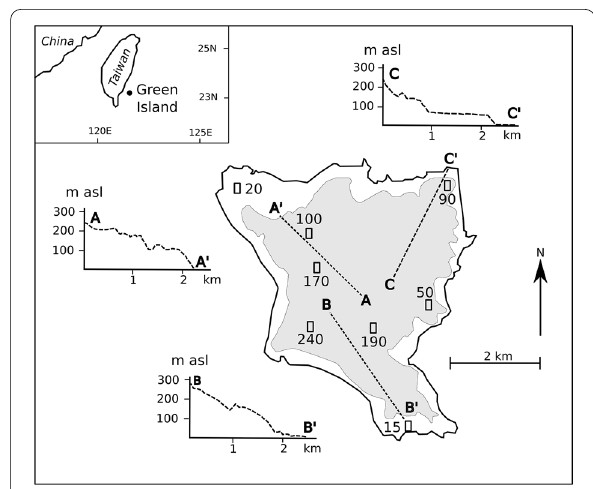
Fig. 1 Location of study sites on Green Island,